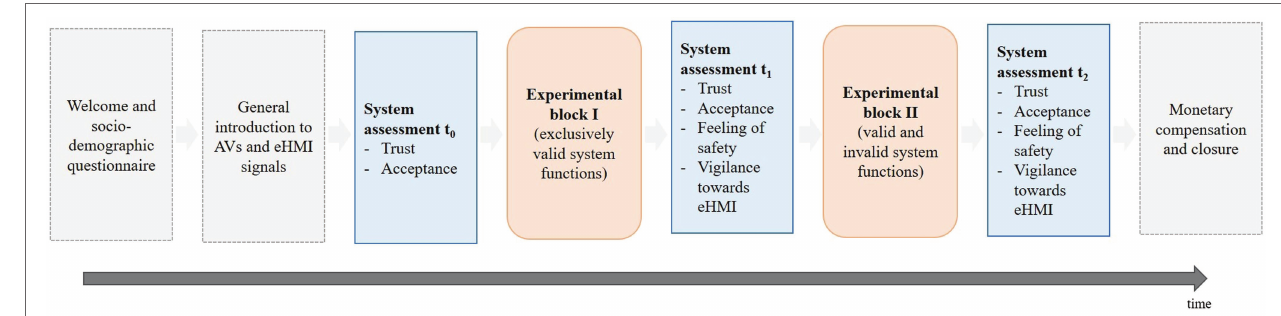
FIGURE 4 | Procedure of the current